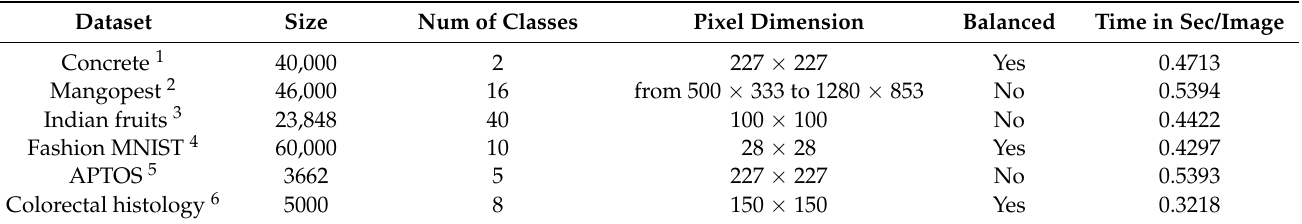
Table 1. Dataset details with preprocessing